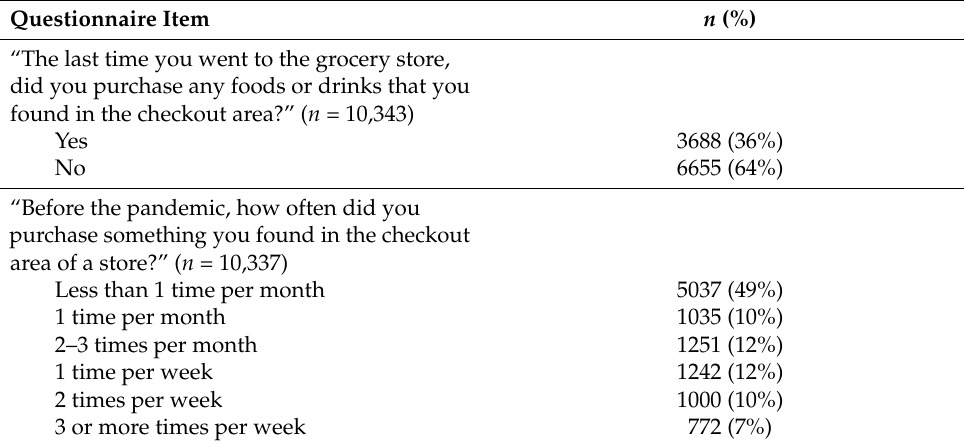
Table 2. Proportion of participants purchasing items from checkout and frequency of this practice in a national sample of US